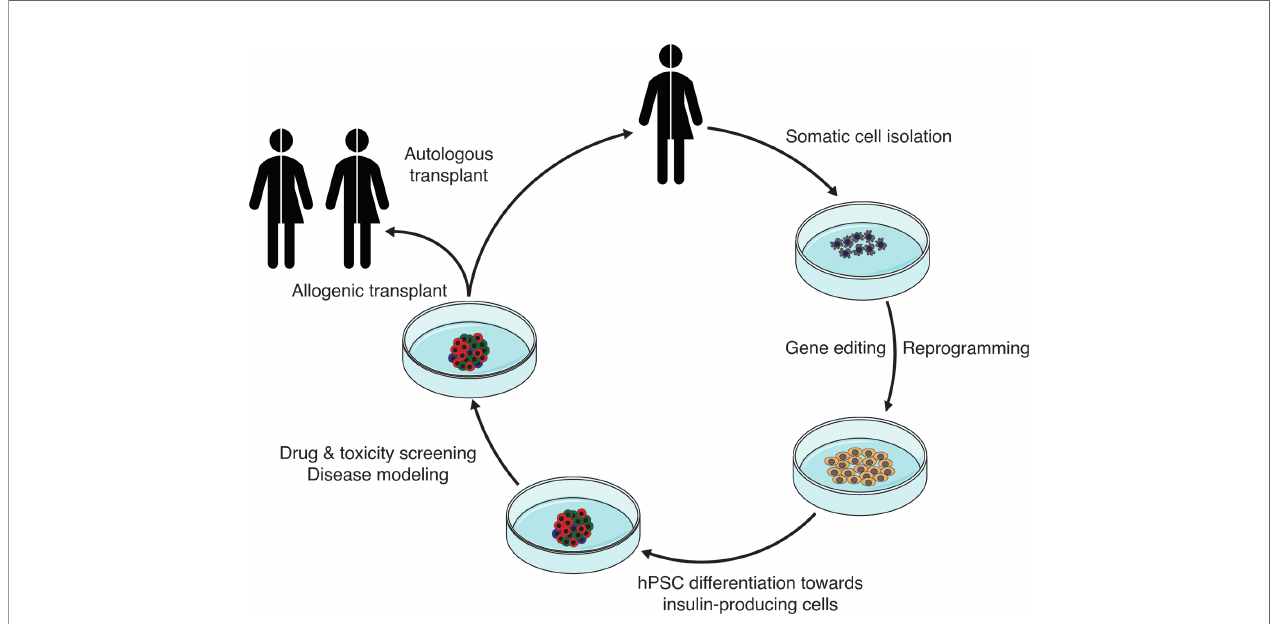
FIGURE 3 | Schematic showing the potential application of stem cell-derived insulin-producing cells for the treatment of